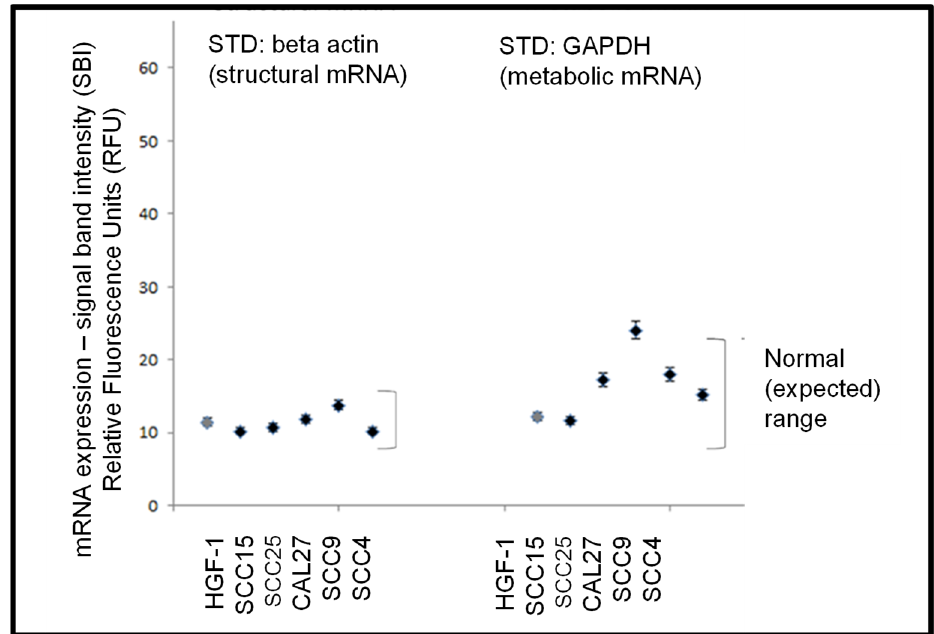
Figure 3. Expression of standard biomarker mRNA. RT-PCR screening of total RNA from each cell line demonstrated mRNA expression levels of the cytoskeletal biomarker beta actin and the metabolic biomarker GAPDH was demonstrated within a defined (expected) range for these cell lines.